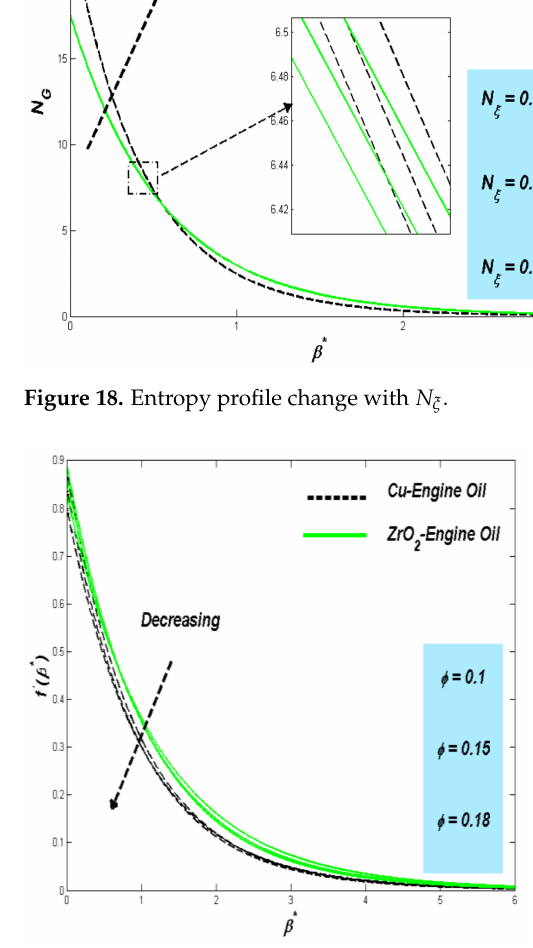
Figure 19. Velocity profile change with φ .